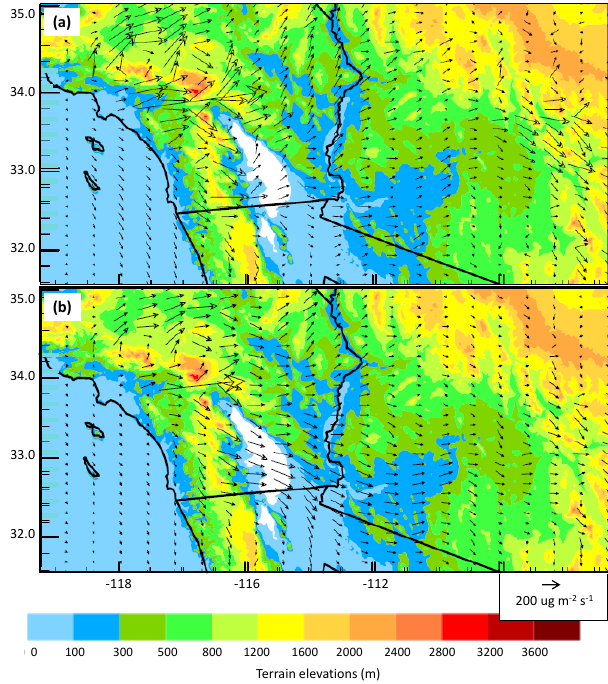
Figure 12. Integrated fluxes of ozone differences (CTRL-noCA) from surface to 1400m above ground-level: (a) average from 18:00 to 02:00UTC, 16 to 20 July 2005, and (b) average from 03:00 to 17:00UTC, 16 to 20 July